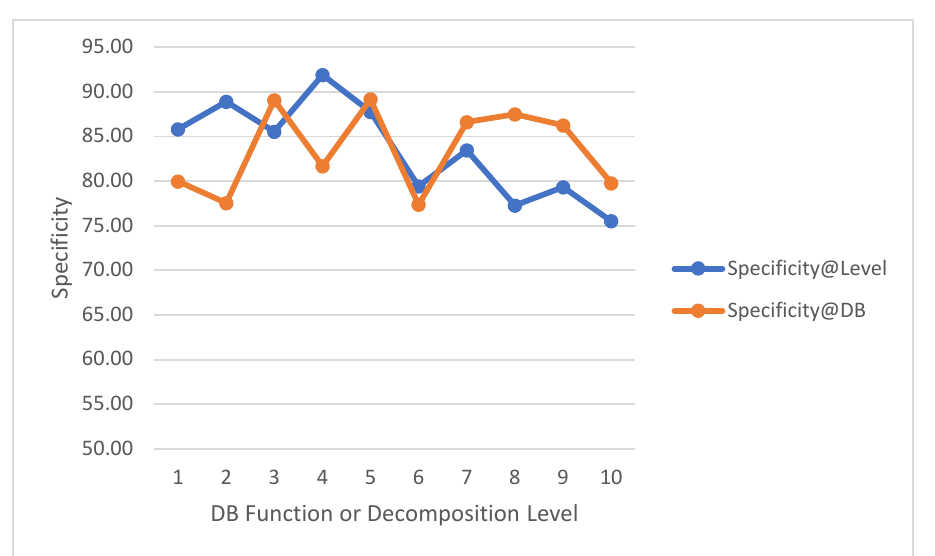
Figure 10. Specificity due to DWBF and DL.